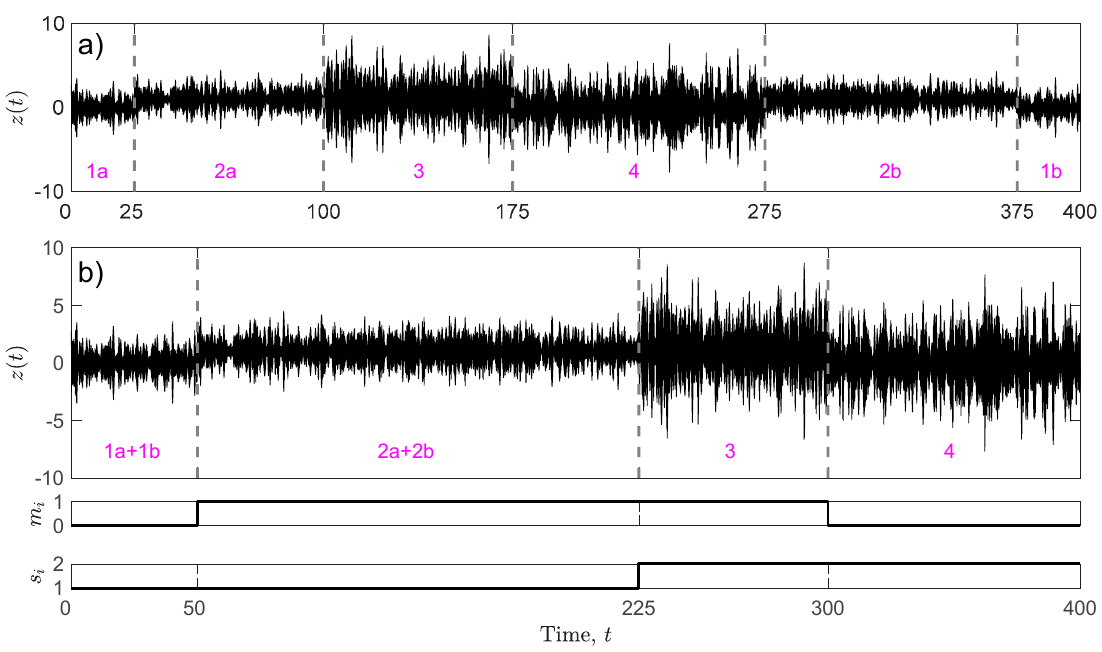
Figure 3. Load A: three states of same duration T S , i ; the values of m i and s i are in bottom subplots.